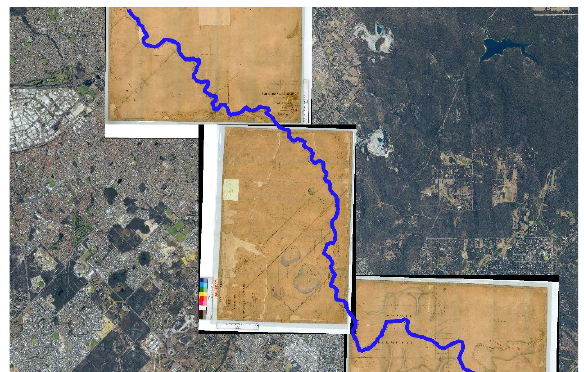
Figure 11: High resolution airborne image with geo-located historical